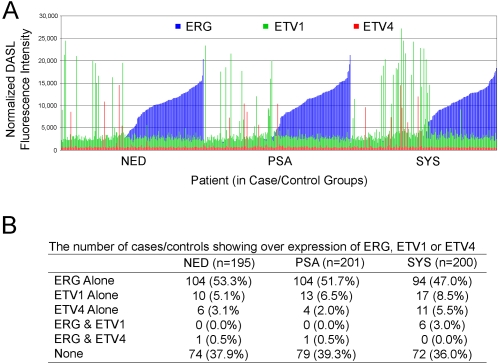
Expression results for ERG, ETV1 and ETV4 among the men with no evidence of disease progression (NED), PSA recurrence (PSA) and systemic progression (SYS).(A) Each overlapping set of three bars (blue, red and green) represent a different case or control. Thresholds for overexpression are ERG>3200, ETV1>6000 and ETV4>1400. (B) The numbers of cases showing overexpression of one or more of ERG, ETV1 and ETV4 are shown.